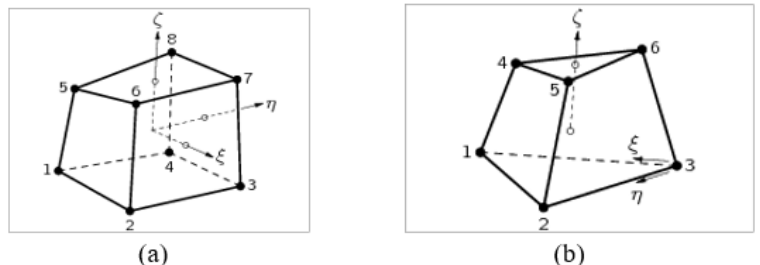
Figure 4. (a) HX24L solid element of the units and grout and (b) TP18L solid element of the steel reinforcement used in the numerical modeling [13].